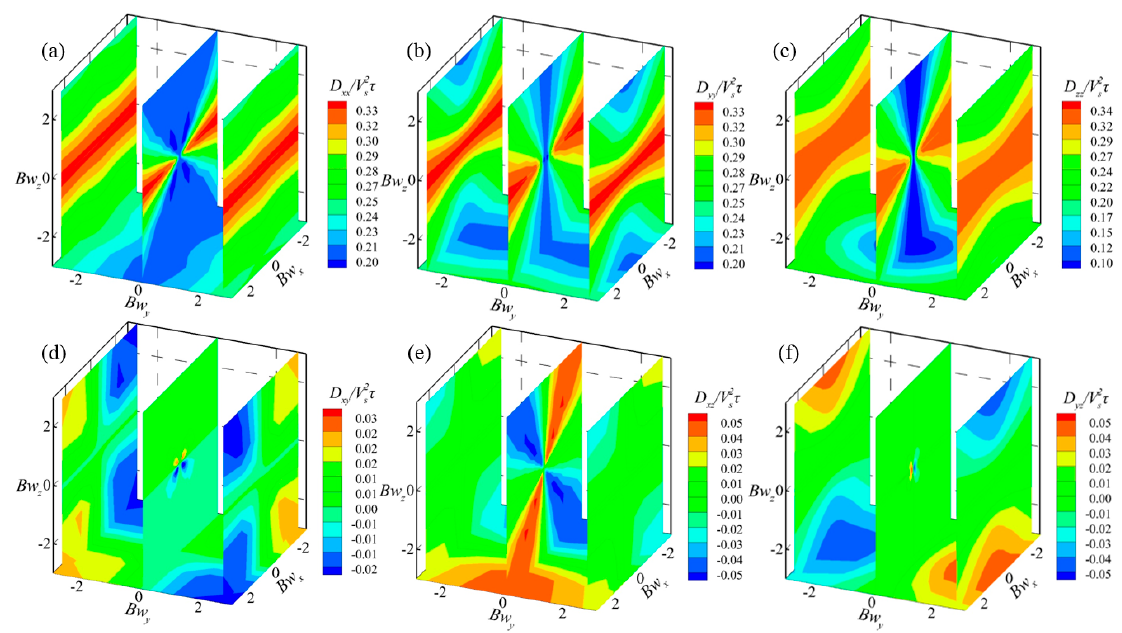
Figure 18. Swimming velocity, ( a ) V x / V s , ( b ) V y / V s , and ( c ) V z / V s with w x , w y , and w z .